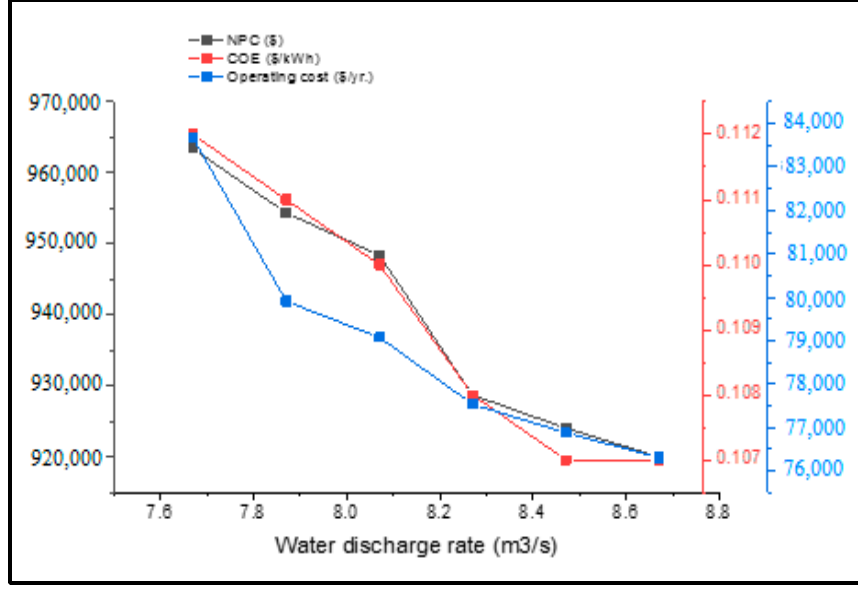
Figure 14. Impact of water streamflow (WSF) on the NPC, COE, and operating cost of the HES.